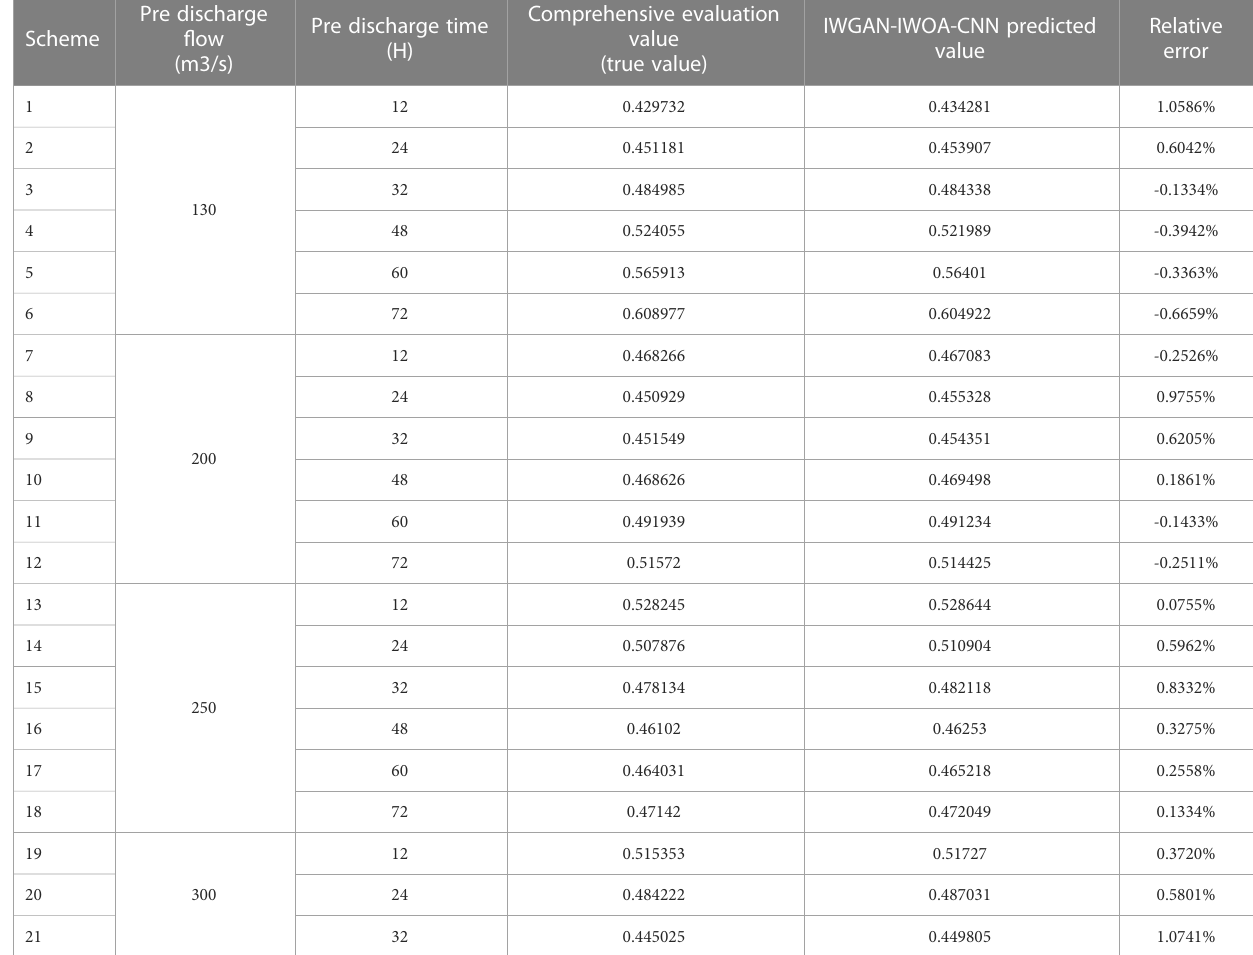
TABLE 6 Selection results of some schemes in dataset